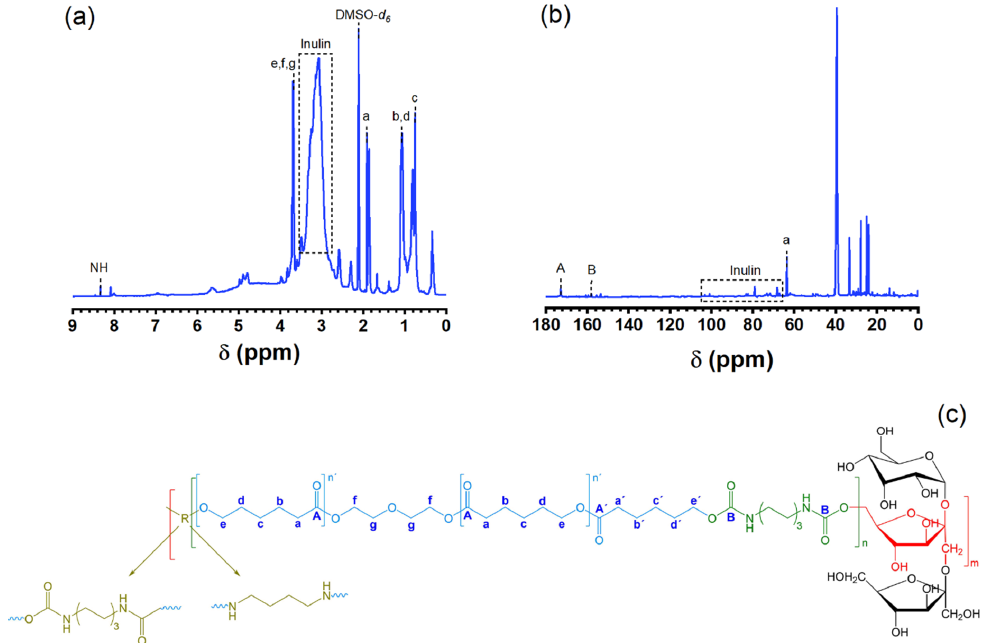
Figure 3. ( a ) 1 H and ( b ) 13 C spectrum of INU33 in dimethyl sulfoxide (DMSO)-d 6 at 500 and 125 MHz, respectively. ( c ) Schematic representation of the suggested structure for PU–INU50 polyurethane. In red color are marked fructans from inulin where m ≈ 36, hexamethylene diisocyanate (HDI) moiety and the urethane linkage are marked in moss-green color, PCL-diol contributions are marked in navy-blue color, HDI or putrescine chain extensor of PU–INU50 are marked in olive-green color and in blue color are marked the letter that corresponds to the chemical moieties observed in NMR.